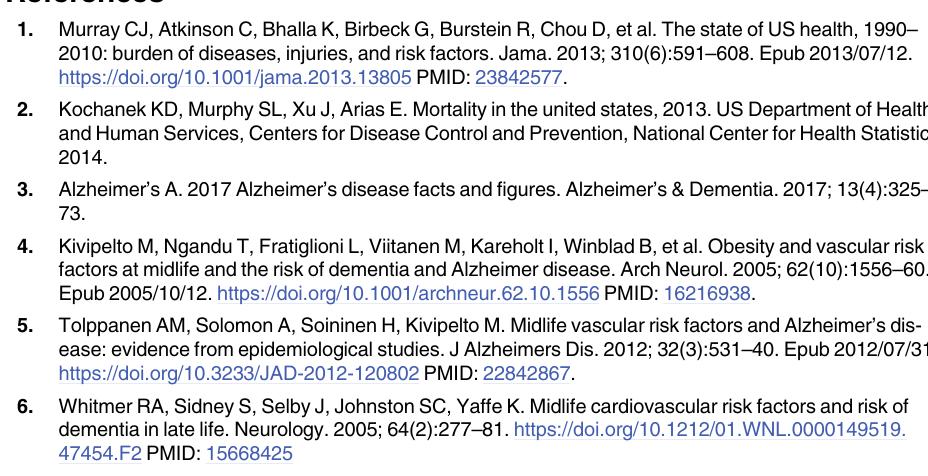
S3 Table. Mean of final non-truncated weights applied in estimation of the MSM at each visit with cognitive data. S4 Table. Weighted demographics demonstrating inverse probability weights recover dis- tribution of characteristics at baseline (Exam